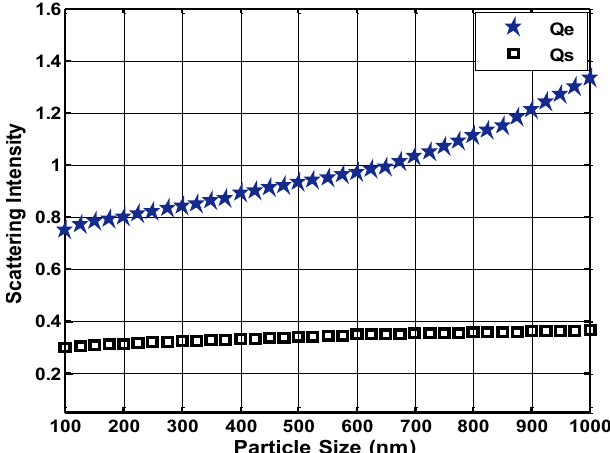
Figure 8. Distribution of scattering intensity in terms of extinction coefficient and scattering coefficient for various coal particle